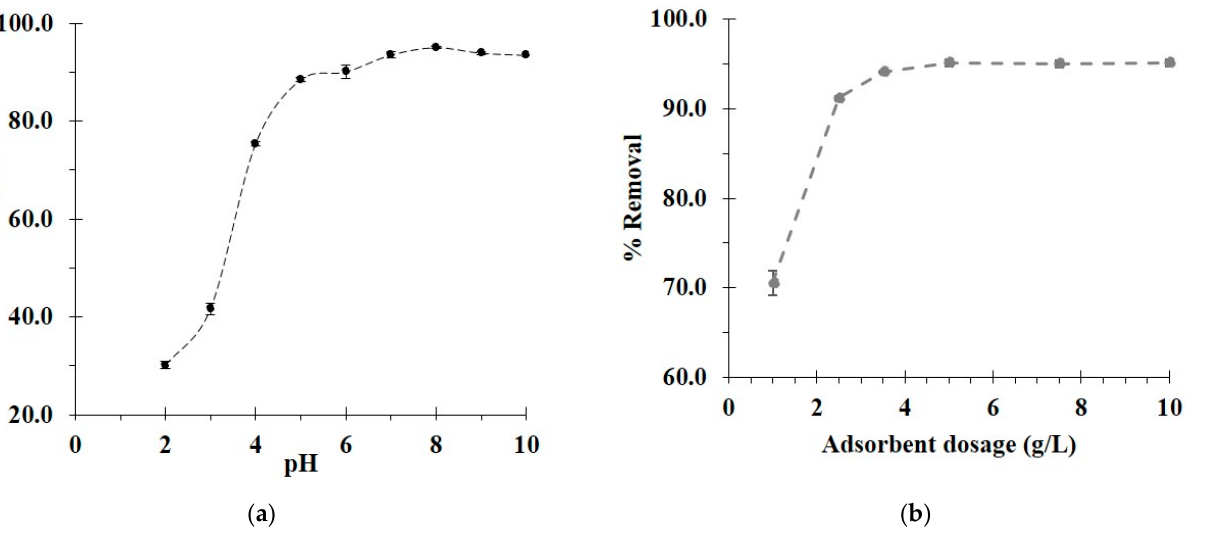
Figure 6. ( a ) Influence of pH on the paraquat removal (conditions: 5 g/L of adsorbent dosage, 25 mg/L of initial concentration, 360 min of contact time, and temperature at 303 K); ( b ) influence of adsorbent dosage on the paraquat removal (conditions: optimal pH, 25 mg/L of initial concentration, 360 min of contact time, and temperature at 303